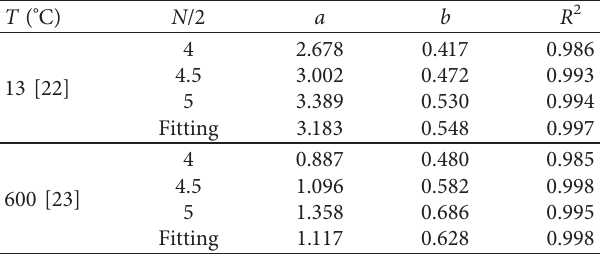
Table 3: Model parameters for different midpoint calculations. T ( °